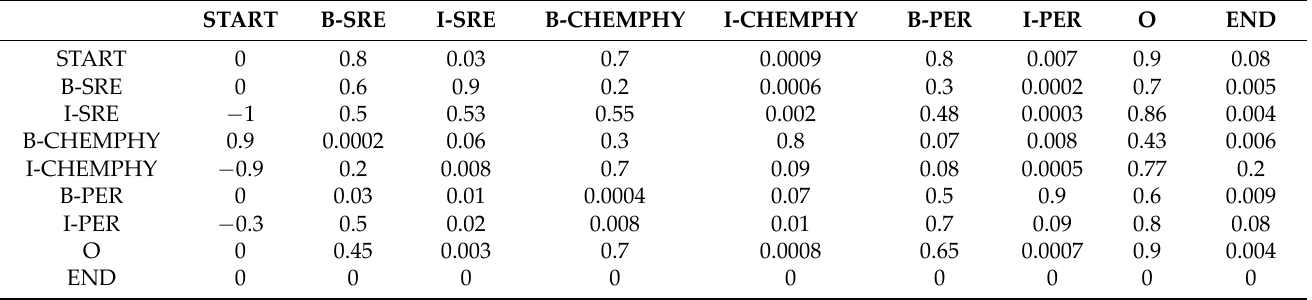
Table 3. Transition